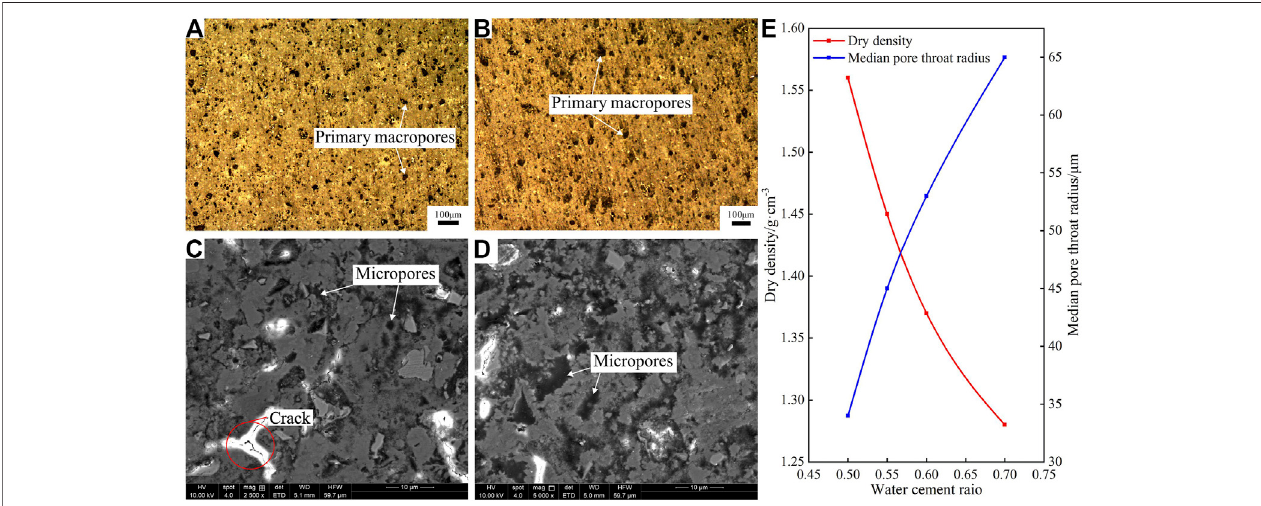
FIGURE2| Microstructureandrelatedparametersofpurecement. (A) Microstructureofpurecement(w/c=0.5)underthemicroscope. (B) Microstructureofpure cement (w/c = 0.7) under the microscope. (C) Microstructure of pure cement (w/c = 0.5) under SEM. (D) Microstructure of pure cement (w/c = 0.7) under SEM. (E) Dry density and median pore throat radius of pure cement.